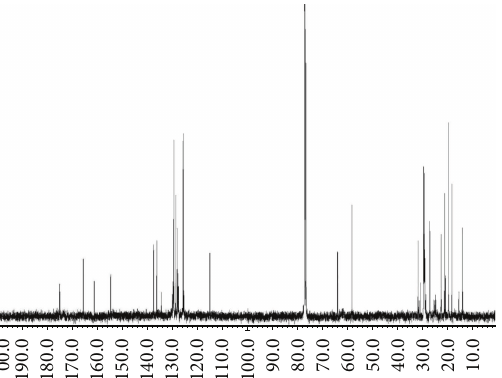
Figure 6: 13 C NMR spectra of